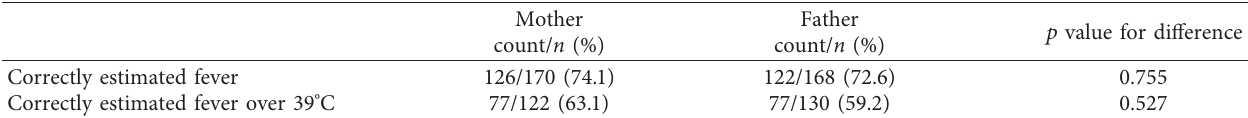
Table 2: Assessment of fever by mothers and